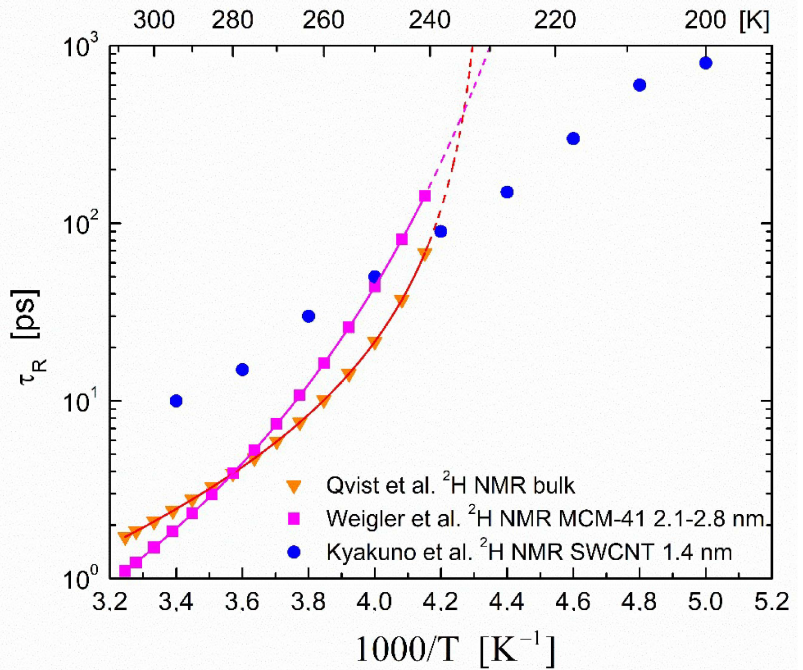
Figure 6. Temperature dependence of the rotational correlation times τ R in bulk and confined heavy water D 2 O. Inverted triangles ( (cid:72) ) are the rotational correlation times τ R of bulk D 2 O obtained from 2 H NMR experiments (Qvist et al. [67]). Filled circles ( • ) are the correlation times for D 1.4 nm SW carbon nanotubes obtained from 2 H T 1 NMR data (Kyakuno et al. [95]). Filled squares ( (cid:4) ) are the rotational correlation times for D 2 O confined in MCM-41 with pores in the range of 2.1–2.8 nm obtained from 2 H T 1 and stimulated-echo experiments (Weigler et al.